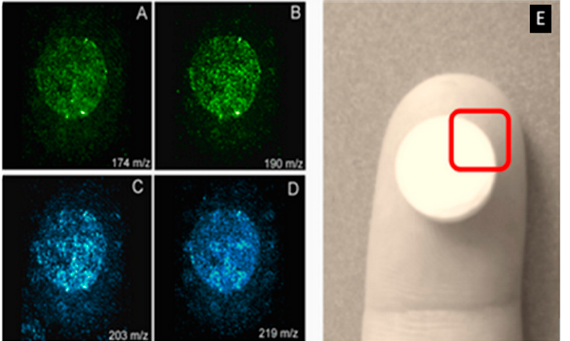
Figure 5. Exogenous compounds in LFM: ( A , B ) acetaminophen and ( C , D ) acetylsalicylic acid. The shape of the object, one round tablet, leaves chemical images that can be seen on the LFM ( E ).